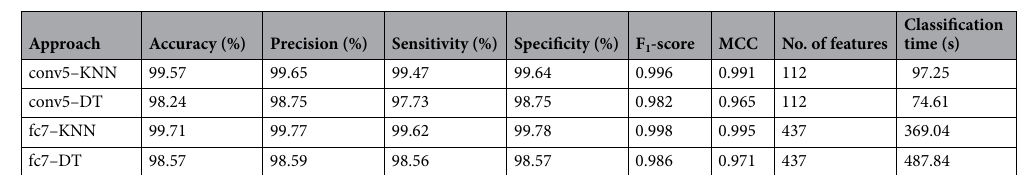
Table 8. Performance of the hybrid approach using the LASSO feature selection technique.